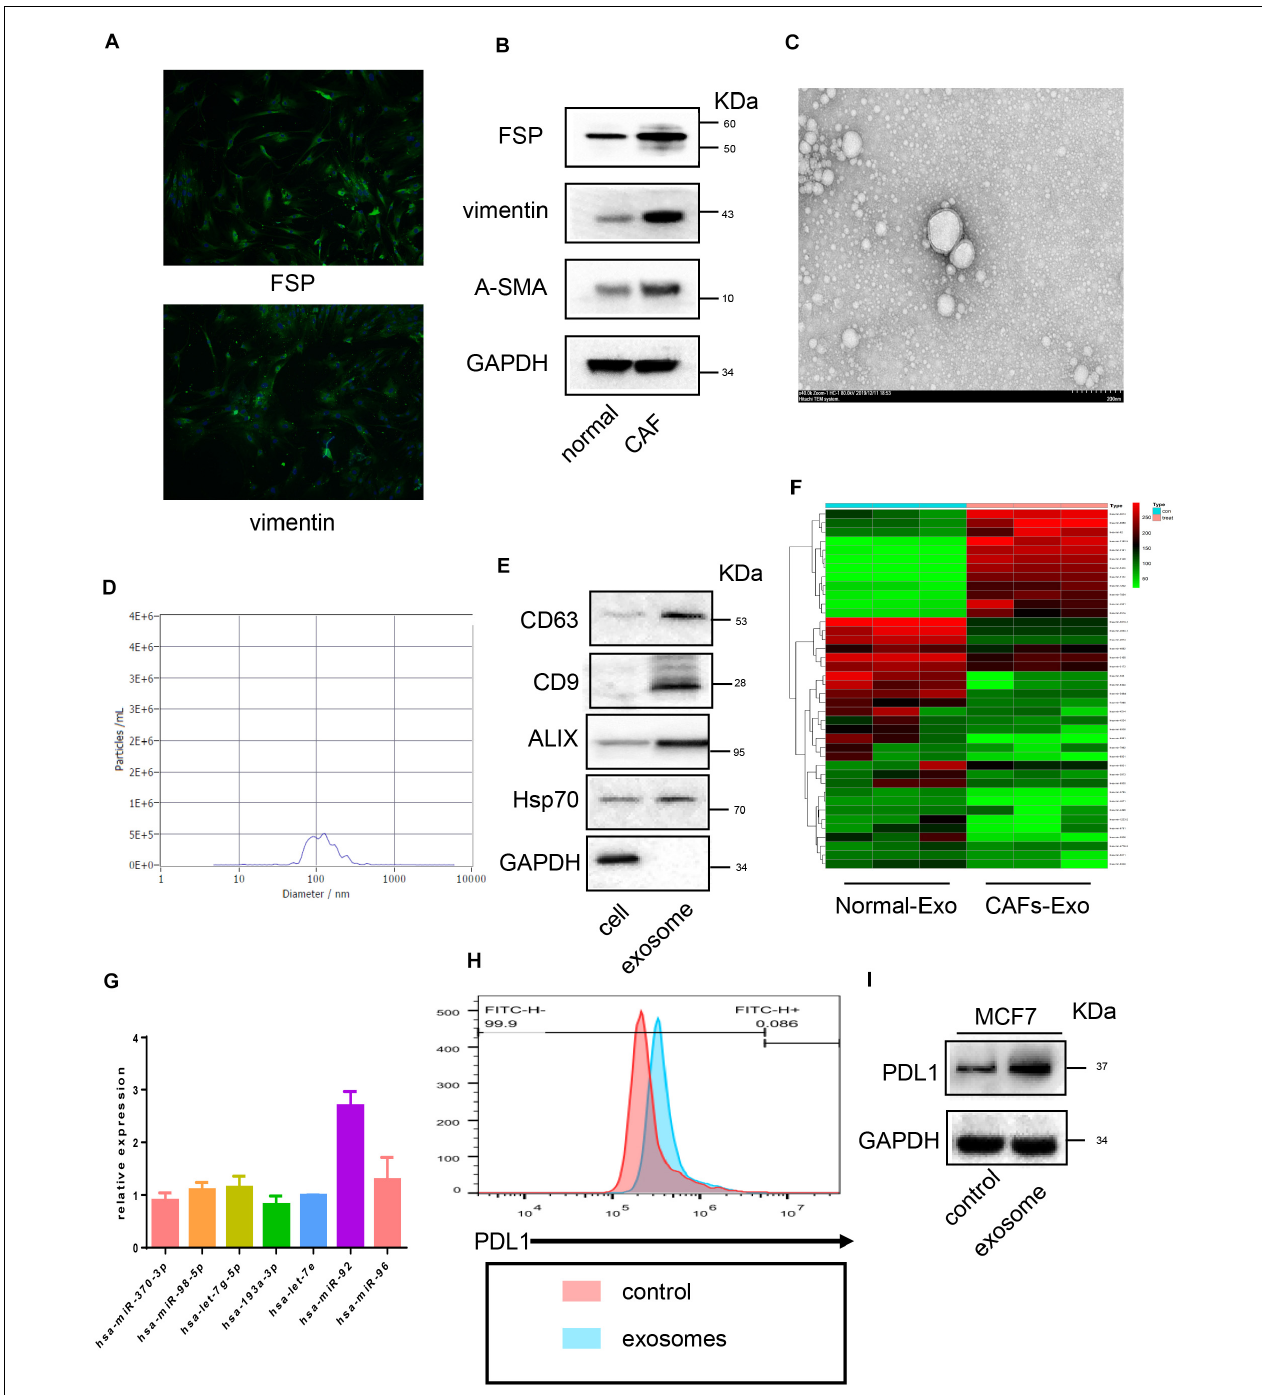
FIGURE 1 | Cancer associated fibroblast-derived exosomes promote miR-92 and PD-L1 expression in breast cancer. (A) Immunofluorescence image of FSP and vimentin in breast cancer-derived cancer associated fibroblasts. (B) Western blot analysis of FSP, vimentin, α -SMA expression in cancer-associated fibroblasts and normal fibroblasts. (C) Transmission electron microscopy image of exosomes. (D) TRPS analysis of exosomes confirming the expected size range of 30–150 nm in diameter. (E) Western blot analysis of exosome markers in CAF-derived exosomes and cell lysates. (F) A clustergram performed hierarchical clustering of the upregulated and downregulated miRNAs in exosomes isolated from CAFs compared with normal fibroblasts cells. The data display a heat map with an indication of co-regulated genes across groups or individual samples. The magnitude of gene expression is presented by colors as indicated by the color bar shown on the right. (G) micro-RNA expression after exosomes treatment (H) flow cytometry analysis of PD-L1 expression in breast cancer cells. (I) PD-L1 expression analyzed by Western blot. Error bars represent mean ± SD; **** P < 0.0001; n.s., not significant; by paired two-sided Student’s t -test.